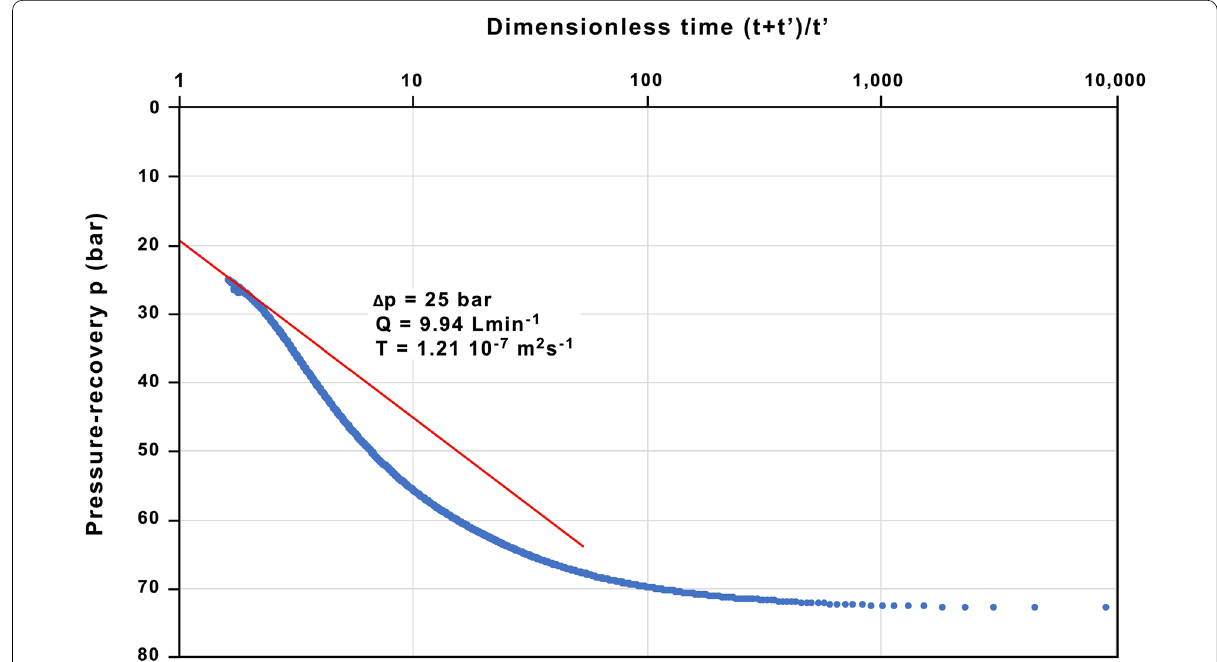
Fig. 5 Evaluation of pressure decline after the injection test (Fig. 3) using the HORNER-plot method (Horner, 1951), with t with Q 9.94 L min − 1 (injection rate of the last injection step) and t’ =